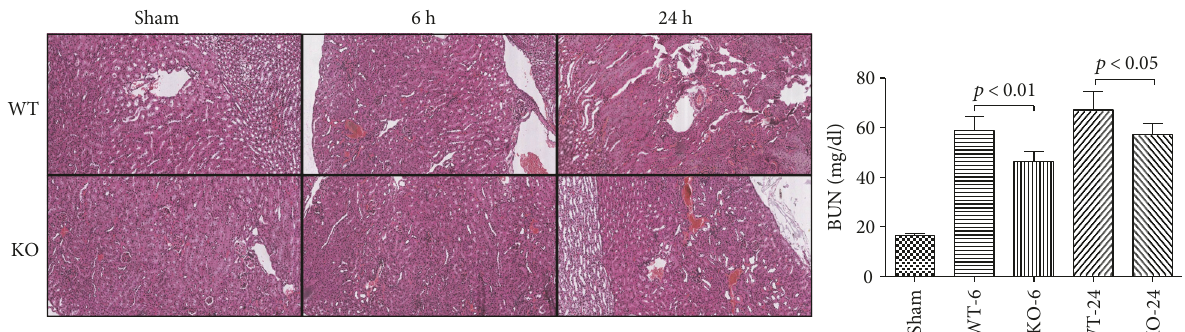
Figure 6: Lack of 5-HT alleviates histopathology damage and organ dysfunction in the kidney in CLP-induced sepsis in mice. The animal blood samples and the kidney tissues were harvested at 6 h or 24h after the CLP administration. H&E staining was conducted as described above. In the kidney, the mice in the KO-CLP sepsis group had less in fl ammatory cell in fi ltration, necrosis, and degeneration. The BUN was calculated as an assessment of renal dysfunction ( n = 6 , BUN: mean ± SD, p < 0 01 versus the WT-CLP group at 6h after the CLP administration; p < 0 05 versus the WT-CLP group at 24 h after the CLP